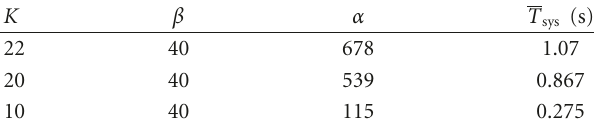
Table 4: T sys versus Available Fine Channels ( K